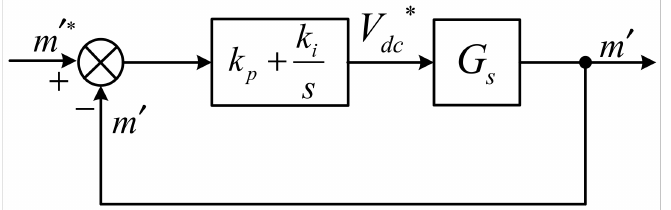
Figure 3. Transfer function block diagram of the fixed SVPWM modulation